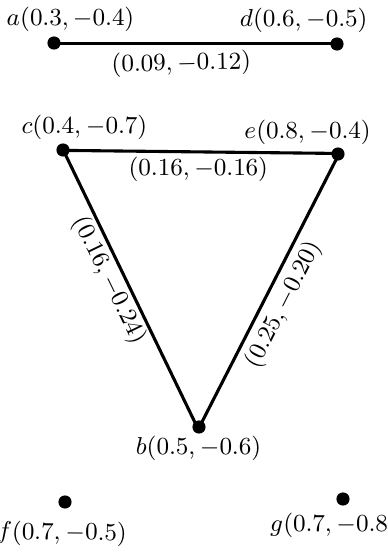
Figure 2. Bipolar fuzzy competition